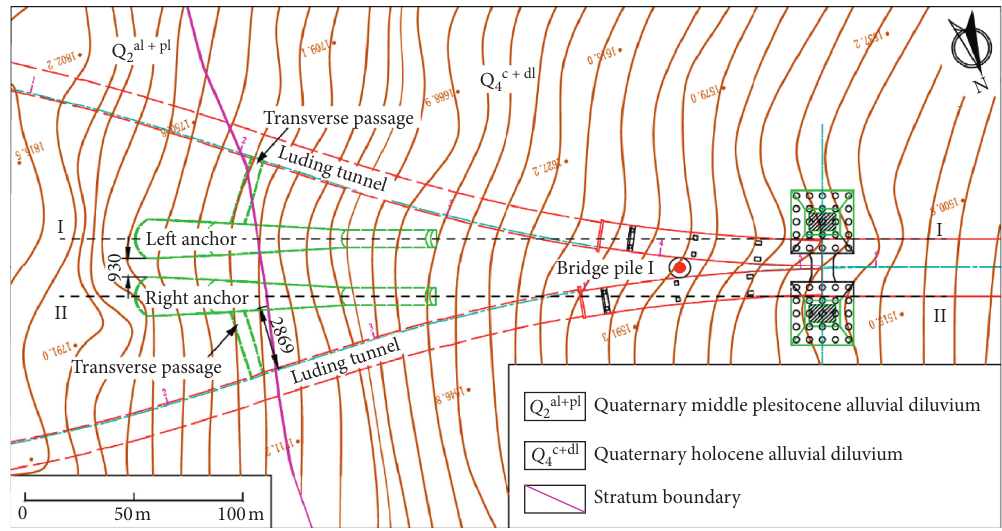
Figure 1: Geography and geology near the tunnel anchor site of the Xingkang Bridge.